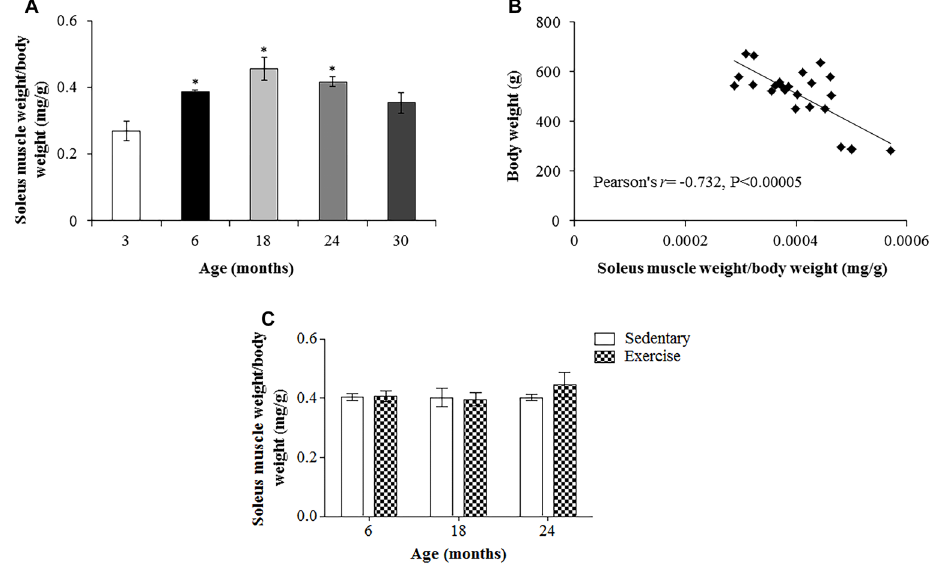
Figure 3. A , Ratio of soleus muscle weight (mg) to total body weight (g) of Wistar rats of different ages. B , Correlation between total body weight and soleus muscle weight/total body weight ratio. C , Effects of 12 weeks of treadmill running on soleus muscle weight (mg)/ total body weight (g) ratio of aged rats. Data are reported as means ± SE. *P o 0.05 compared to 3-month-old rats (repeated-measures ( A ) and two-way ANOVA ( B ) followed by Tukey ’ s post hoc